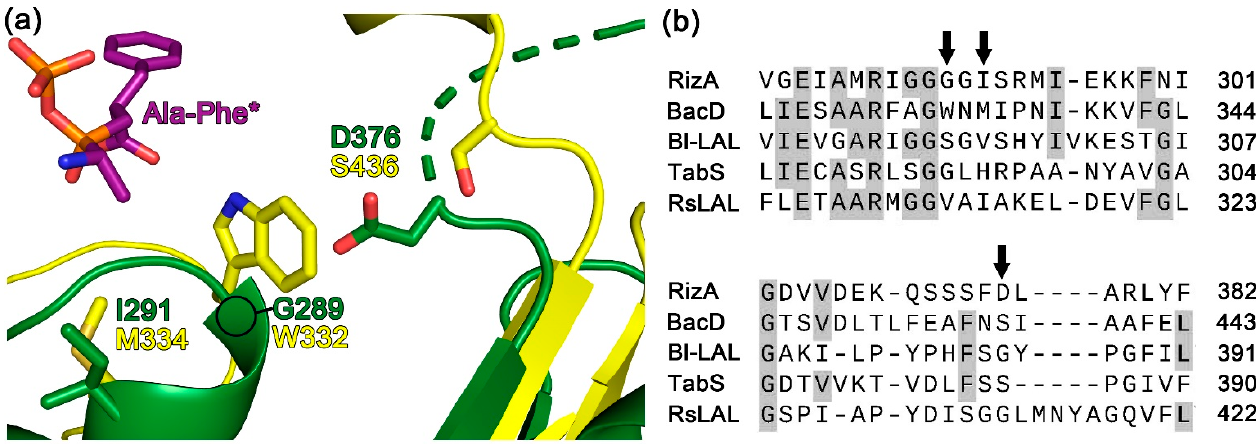
Figure 3. Residues in the N-terminal binding pocket. ( a ) Structural alignment of RizA (green; PDB ID: 4wd3) with BacD (yellow; PDB ID: 3vmm) containing Ala-Phe analog (purple) The structures were displayed using PyMOL [29] . ( b ) Sequence alignment of RizA with other LALs. Arrows indicate positions that were mutated in RizA. Grey highlighting indicates conservation above 50%.